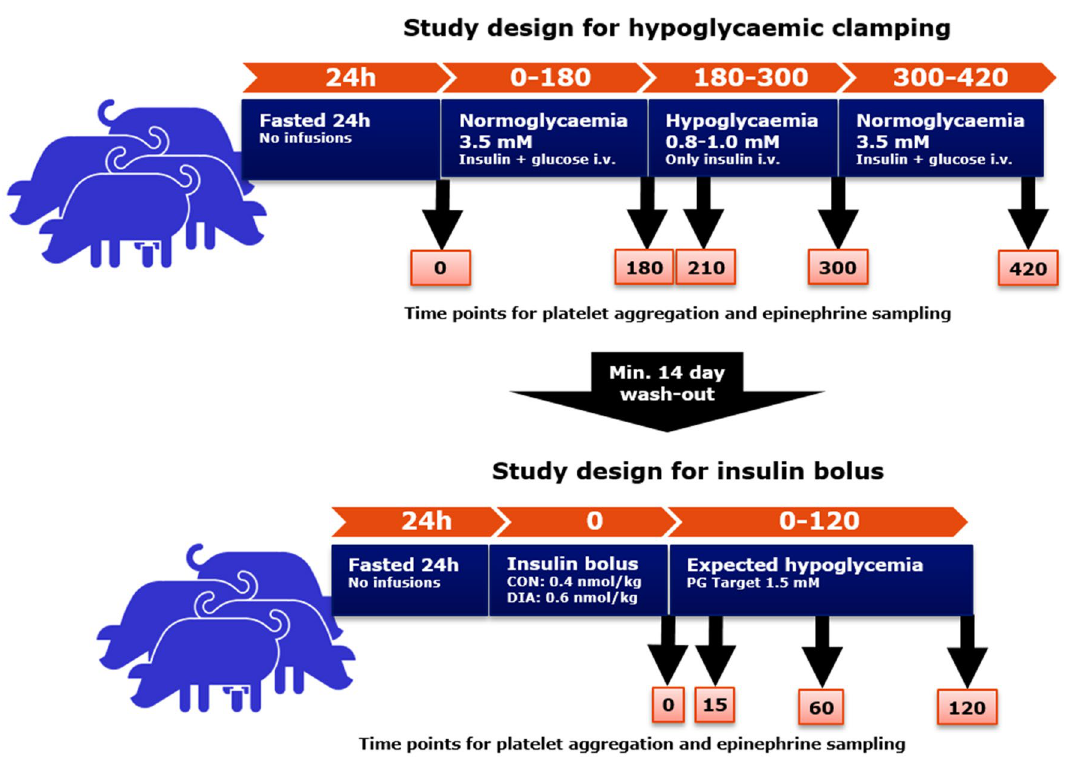
Figure 1. Study design. Hyperinsulinaemic, hypoglycaemic clamp protocol: Pigs were fasted for 24 h prior to study. Pigs received a constant infusion of human insulin (16 pmol/kg/min) throughout the study. A variable glucose infusion (GIR) was given to regulated plasma glucose (PG) to a desired level. PG was measured every five to fifteen minutes. PG target for the first 180 min of study was 3.5 mM (normoglycaemia). After 180 min, GIR was completely turned off, without turning of the insulin, to induce a rapid drop in PG. After initial drop, GIR were carefully increased on to obtain PG target of 0.8–1.0 mM (hypoglycaemia). At 300 min, GIR was increased to obtain normoglycaemia until study end at 420 min. Time-points for epinephrine and platelet aggregometry sampling is illustrated below. Insulin bolus protocol: the bolus protocol was initiated following a minimum 14 day wash-out period. Pigs were fasted for 24 h prior to study. At time 0 min, pigs received an intravenous human insulin bolus (control group (CON) 0.4 nmol/kg, diabetic (DIA) group 0.6 nmol/kg). PG was measured every five to fifteen minutes. Time-points for epinephrine and platelet aggregometry sampling is illustrated below. Software used to generate graphics: Microsoft PowerPoint